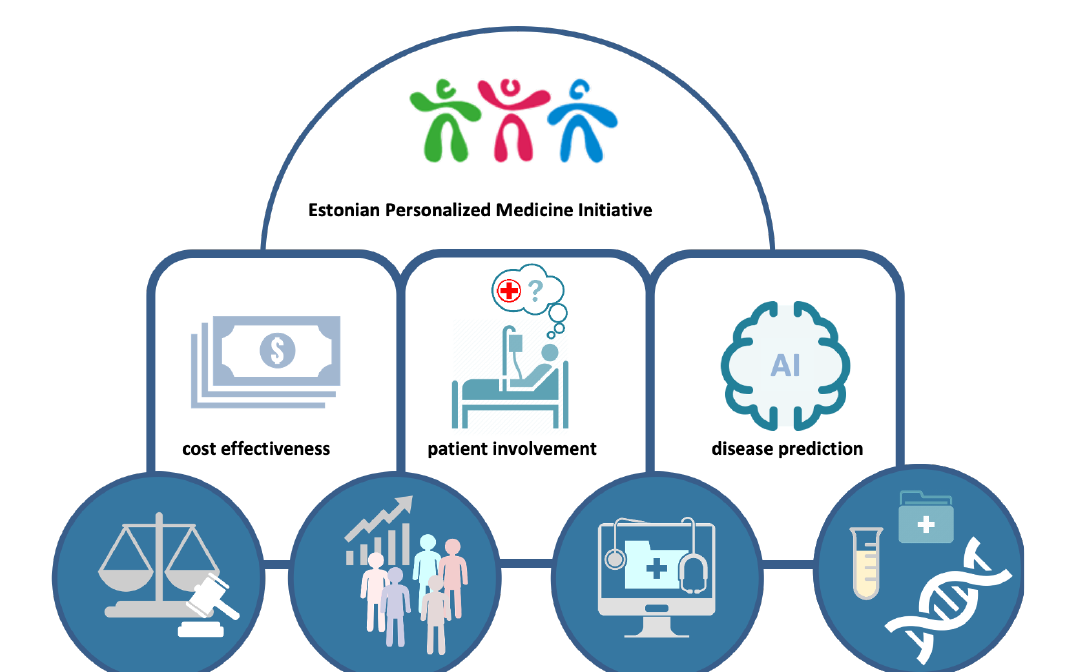
Figure 2. Implementation of personalized medicine. Four core elements (circles) that represent strategic advantages enabling the Estonian Personalized Medicine Initiative to be effectively realized.